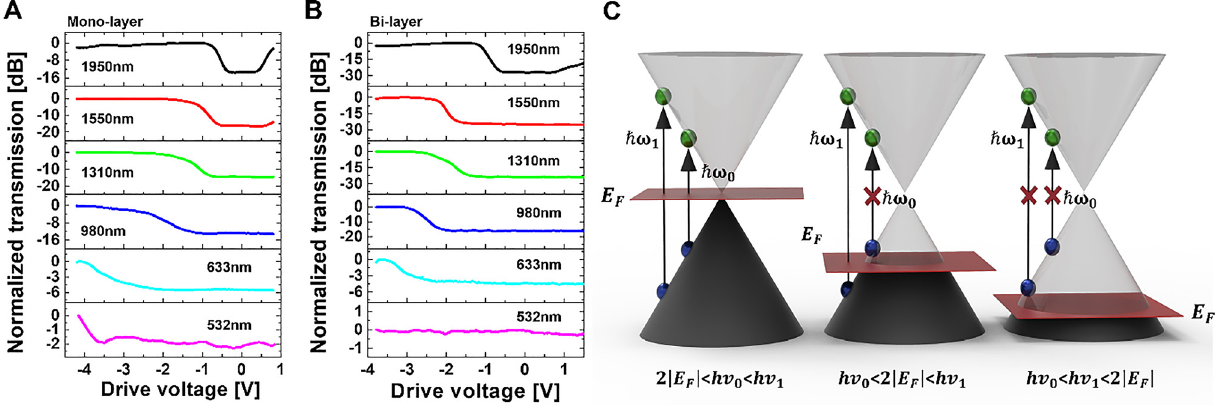
Figure 4: Electro-optic response of (A) monolayer and (B) bilayer graphene devices as a function of applied drive voltage for several wavelengthsof532,671,980,1310,1550,and1950nm.(C)SchematicrepresentationofPauliblockingforlightwithdifferentphotonenergyin graphene.